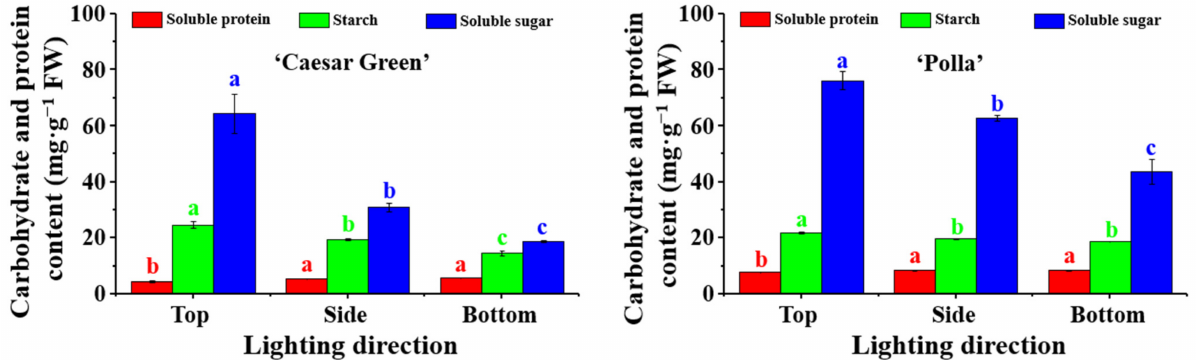
Figure 7. Effect of the lighting direction on the carbohydrate and protein contents in leaves of lettuce Caesar Green and Polla. Vertical bars indicate the means ± stand error ( n = 3). Different small letters indicate the significant separation within treatments by the Duncan’s multiple range test at p ≤ 0.05.